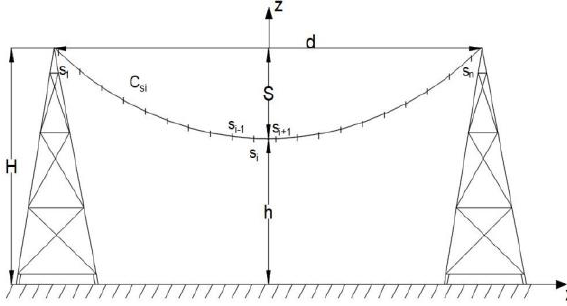
Fig. 1. The power line conductor division of into n